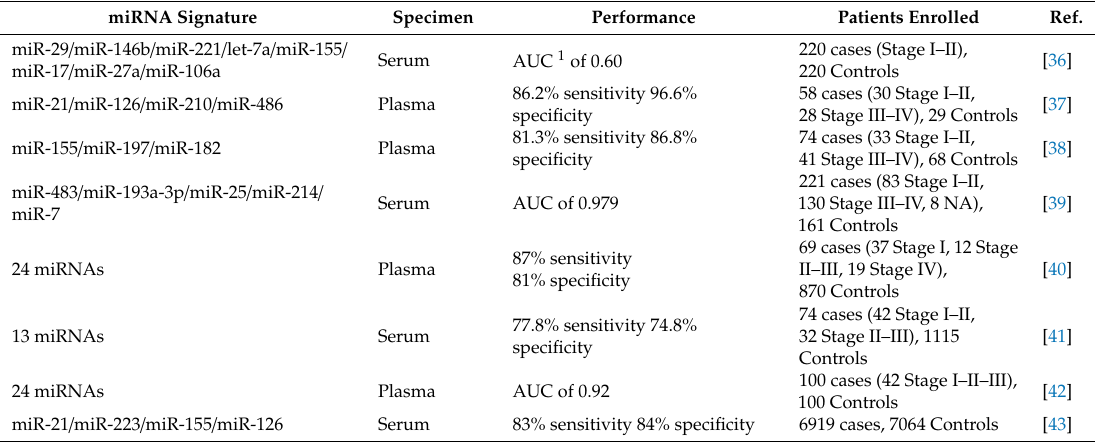
Table 1. Circulating miRNAs for lung cancer